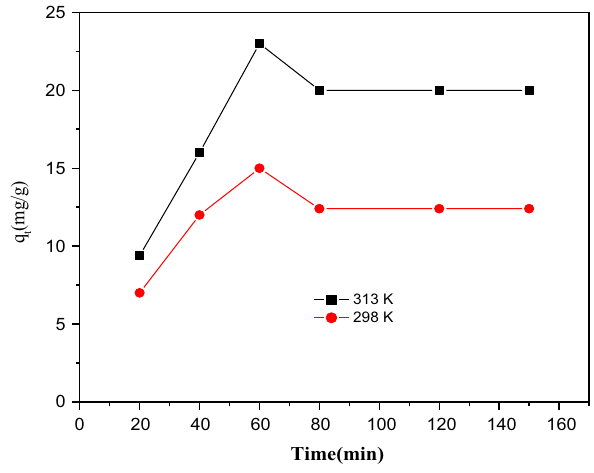
Fig. 6 Effect of contact time on PC-G removal efficiency on MgO nanoparticles. ( C 0 = 50 mg/L, dosage = 1.5 g/L, and pH =